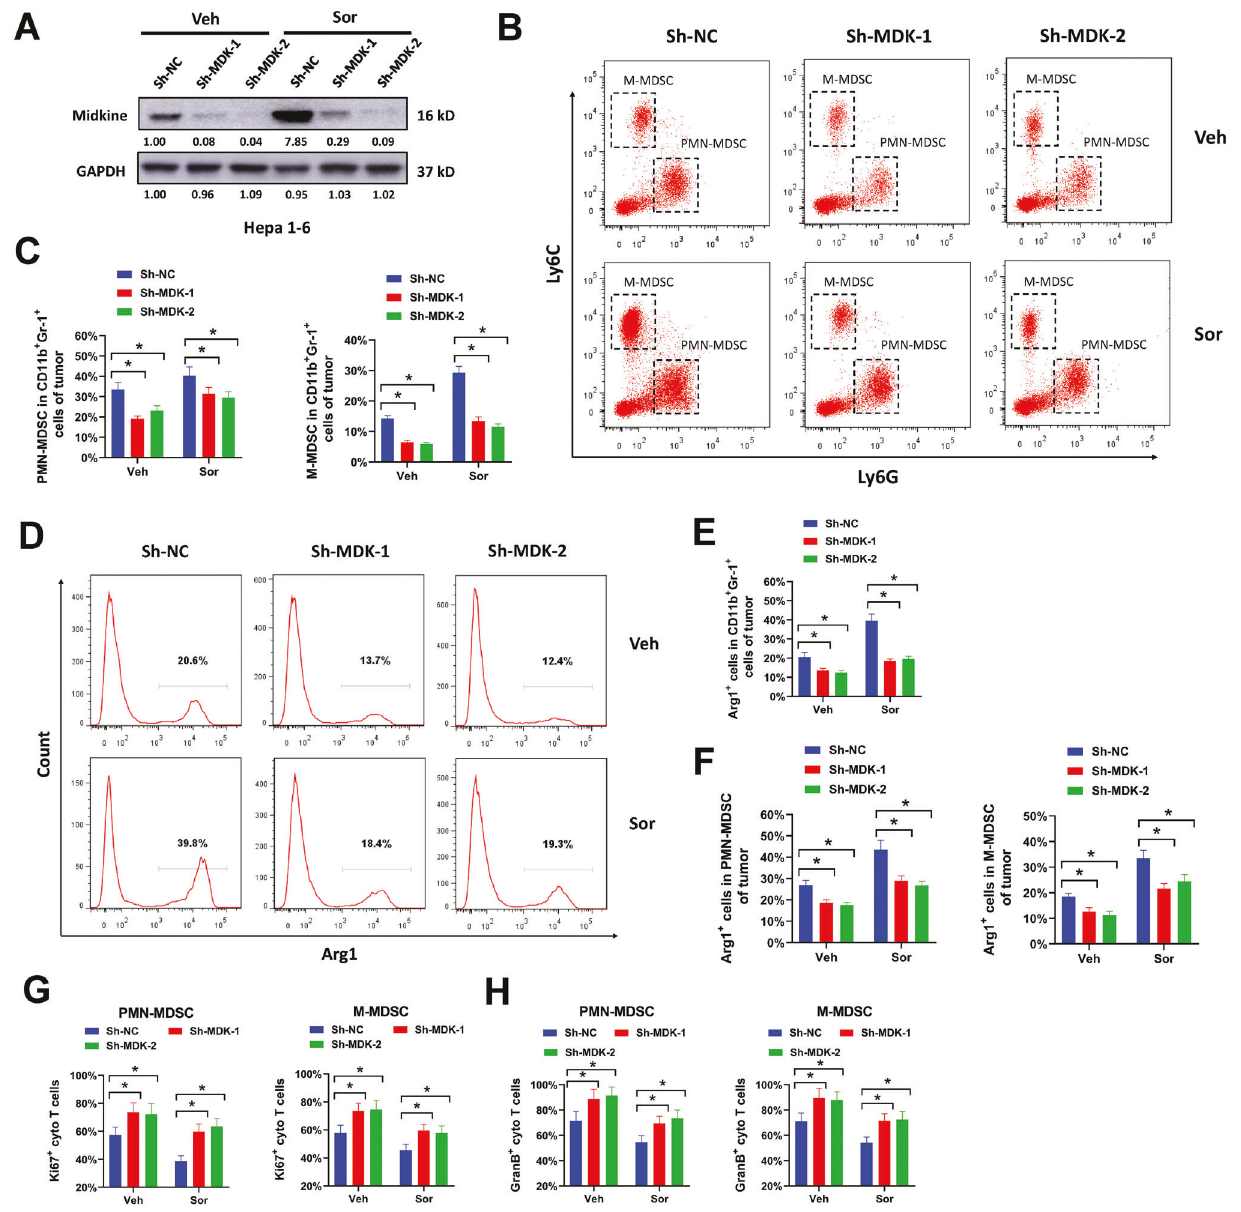
Fig. 5 Midkine inhibition prevents immunosuppressive MDSCs in fi ltrating into HCC tumors. Hepa 1-6 cells transduced with Sh-MDK-1, Sh- MDK-2 or Sh-NC lentivirus were orthotopically implanted into the liver of C57BL/6 mice, then treated with sorafenib (Sor) or vehicle control (Veh) for three weeks. A protein expression of midkine in midkine-depleted orthotopic Hepa 1-6 tumors was validated by western blot. B , C Ly6C int Ly6G + PMN-MDSCs and Ly6C high Ly6G - M-MDSCs in intratumoral CD11b + Gr-1 + subset of midkine-depleted orthotopic Hepa 1-6 tumors were evaluated by fl ow cytometry. D – F Arg1 + cells in in fi ltrating CD11b + Gr-1 + subset ( D – E ) and MDSCs subset ( F ) of midkine- depleted orthotopic Hepa 1-6 tumors were evaluated by fl ow cytometry. G , H in fi ltrating PMN-MDSCs and M-MDSCs of midkine-depleted orthotopic Hepa 1-6 tumors were used for T-cell suppression assay. Ki67 + ( G ) and Granzyme B + ( H ) cytotoxic T cells were evaluated by fl ow cytometry. All assays were done with at least three repeats. Data were shown as mean ± s.d., * P < were used in T-cell suppression assay. MDSCs derived from (Supplementary Fig. 8A). The immunosuppression activity of midkine-overexpressing Hepa 1-6 tumors signi fi cantly inhibited MDSCs is acted through various mechanisms. Among them, IL- the proliferation and activation of cytotoxic T cells compared with 10 secreted by MDSCs promotes immunosuppression via target- MDSCs derived from EV-transduced tumors, but the addition of ing a variety of immune cells [30]. In our study, IL-10 expression neutralizing antibodies against IL-10 largely abrogated these was signi fi cantly upregulated in sorafenib-treated HCC tumors effects (Fig. 7D, E). Furthermore, CD11b + CD33 + HLA-DR - MDSCs (Fig. 1E). Moreover, MDSCs sorted from midkine-overexpressing Hepa 1-6 tumors showed elevated IL-10 expression and produc- induced by conditional medium from midkine-overexpressing tion compared with MDSCs derived from EV-transduced tumors HUH-7 and SNU-449 cells showed increased IL-10 expression and (Fig. 7B, C). To clarify the potential role of IL-10 in immunosup- secretion compared with MDSCs induced by conditional medium pression activity of MDSCs, neutralizing antibodies against IL-10 from EV-transduced cells (Supplementary Fig. 8B and C).